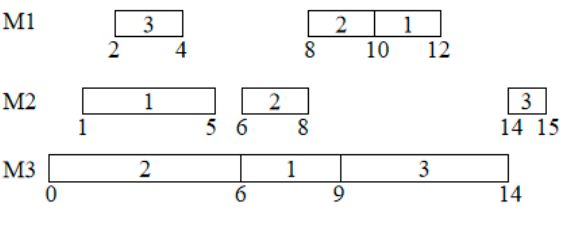
Figure 1. Gantt chart of SPT-DS heuristic.